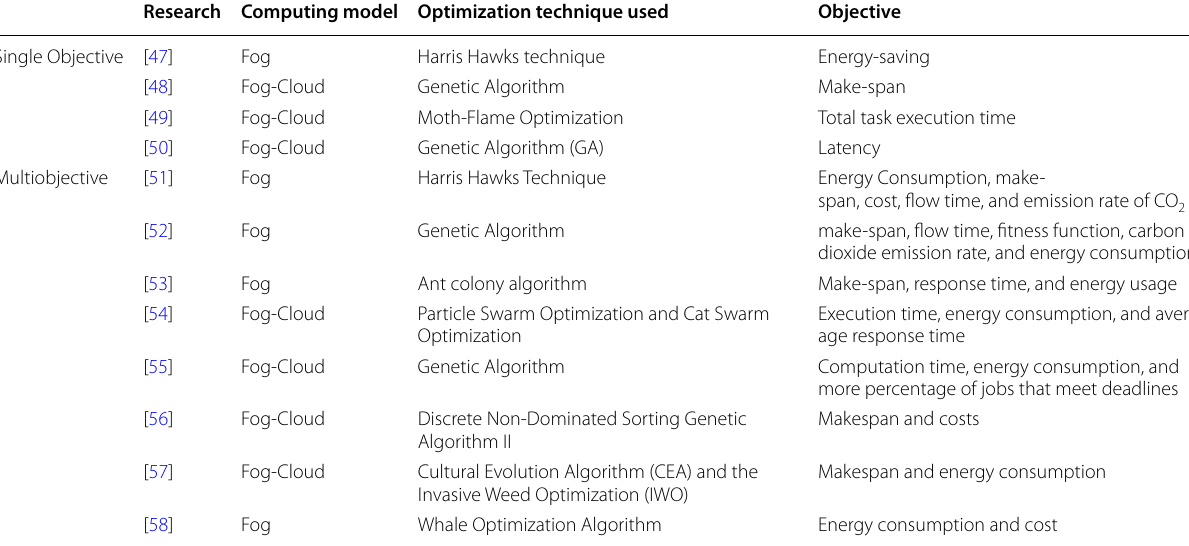
Table 2 Meta-Heuristics used in fog integrated cloud environment Research Computing model Optimization technique